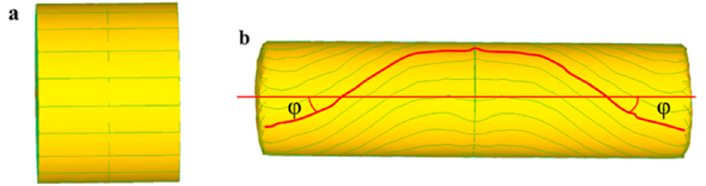
Figure 3. Results of finite element simulation of metal crimping of simple shaft: ( a ) billet; ( b ) rolled piece.